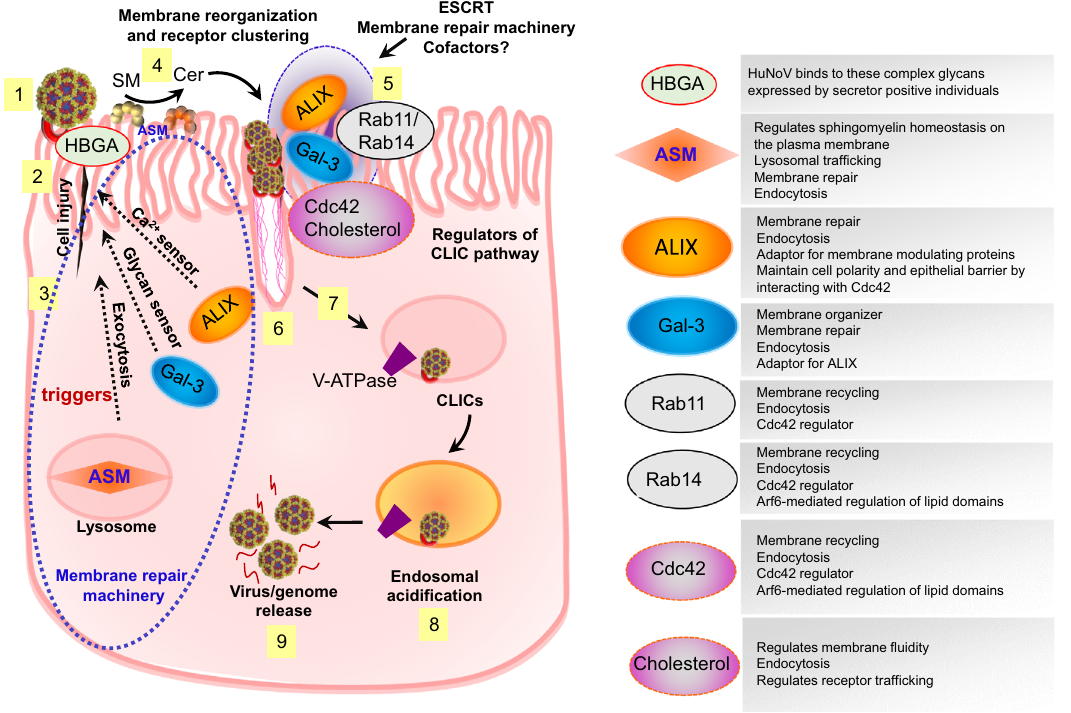
Fig. 6 | GII.4 uses a complex entry mechanism involving cellular wound repair mechanisms and CLIC-mediated endocytosis. (1) Binding of GII.4 with its glycan receptor (HBGAs and possibly with a still unidenti fi ed co-receptor) on the cell surface(2)inducesplasmamembrane wounding(3)triggeringsignaling responses that direct multiple membrane repair cellular components to the injury site. (4) ASM translocation to the plasma membrane surface results in conversion of sphingomyelin (SM) to ceramide. (5) Ceramide formation along with other mem- brane repair processes involving gal-3 (glycan damage sensor), ALIX (Ca 2+ sensor)